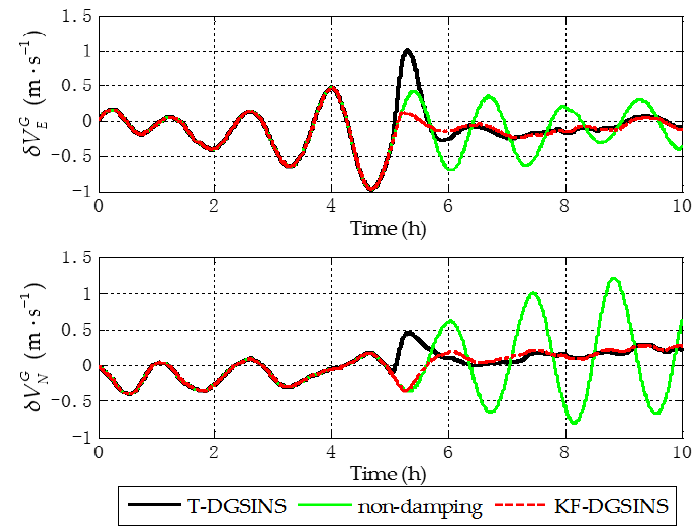
Figure 14. Grid level velocity errors of the semi-physical simulation results.